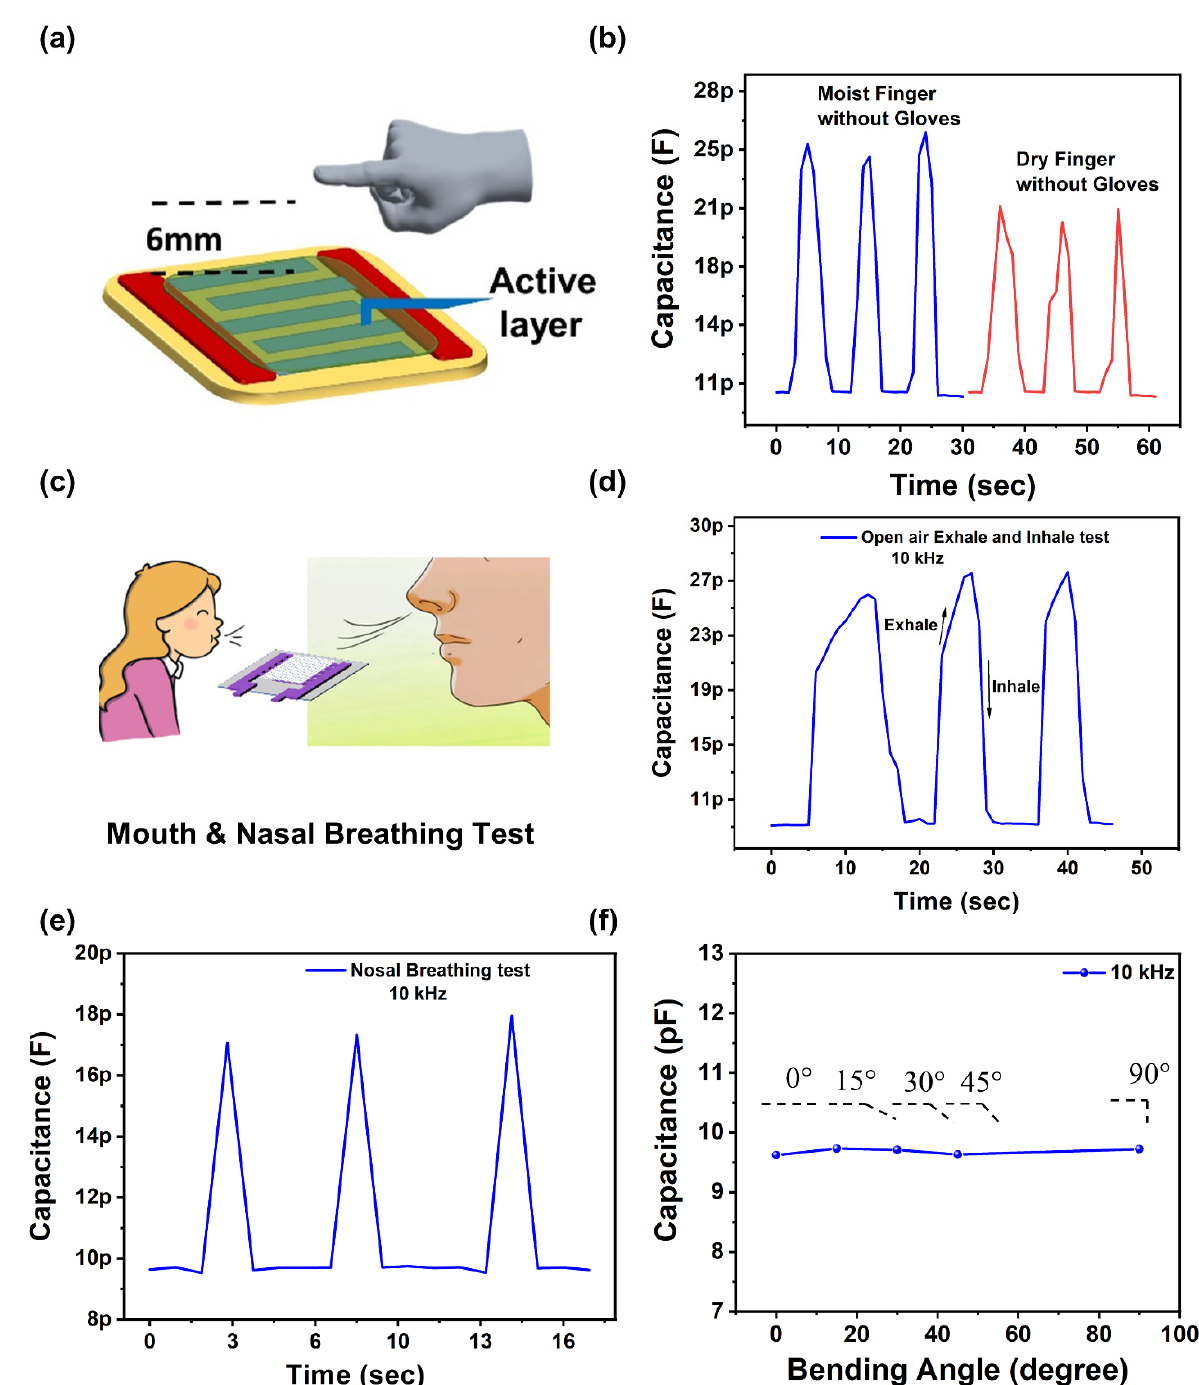
Figure 4. ( a ) Schematic diagram of contactless humidity sensing test of proposed sensor. ( b ) Capacitance response of moist finger and dry finger without gloves for contactless sensing experiments. ( c ) Schematic diagram Mouth and Nasal Breathing test of proposed sensor. ( d ) Schematic diagram of mouth breathing test of proposed sensor. ( e ) Capacitance curves of open-air exhale and inhale test. ( f ) Capacitance of the sensor when it is bended at different angles.